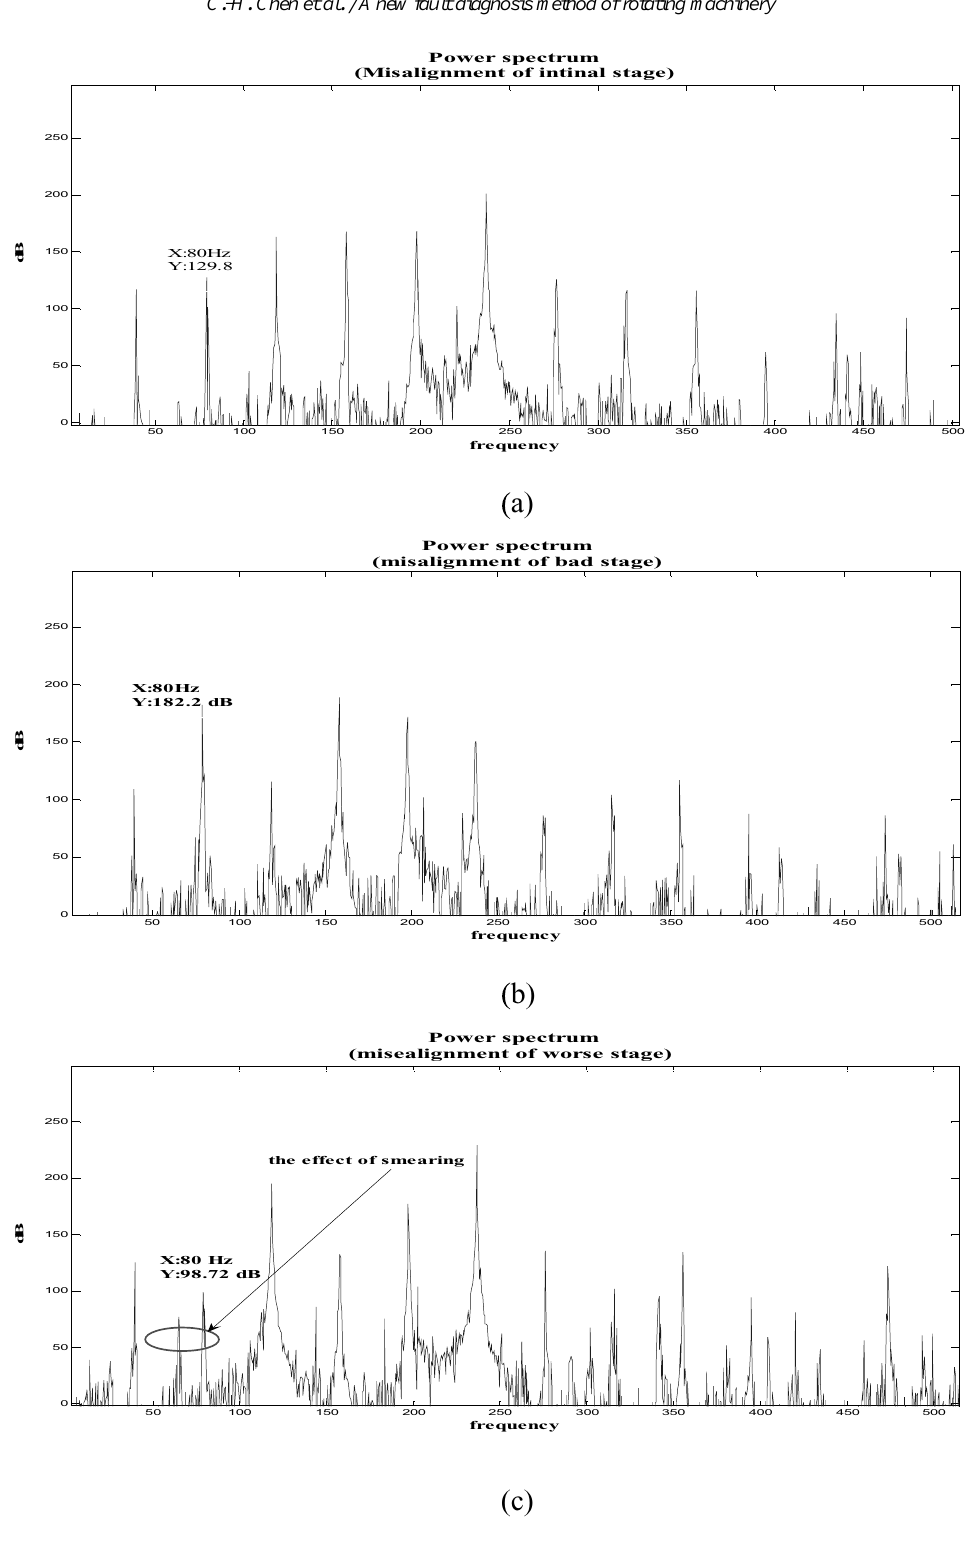
Fig. 8. The smearing effect in the power spectrum of fault condition C